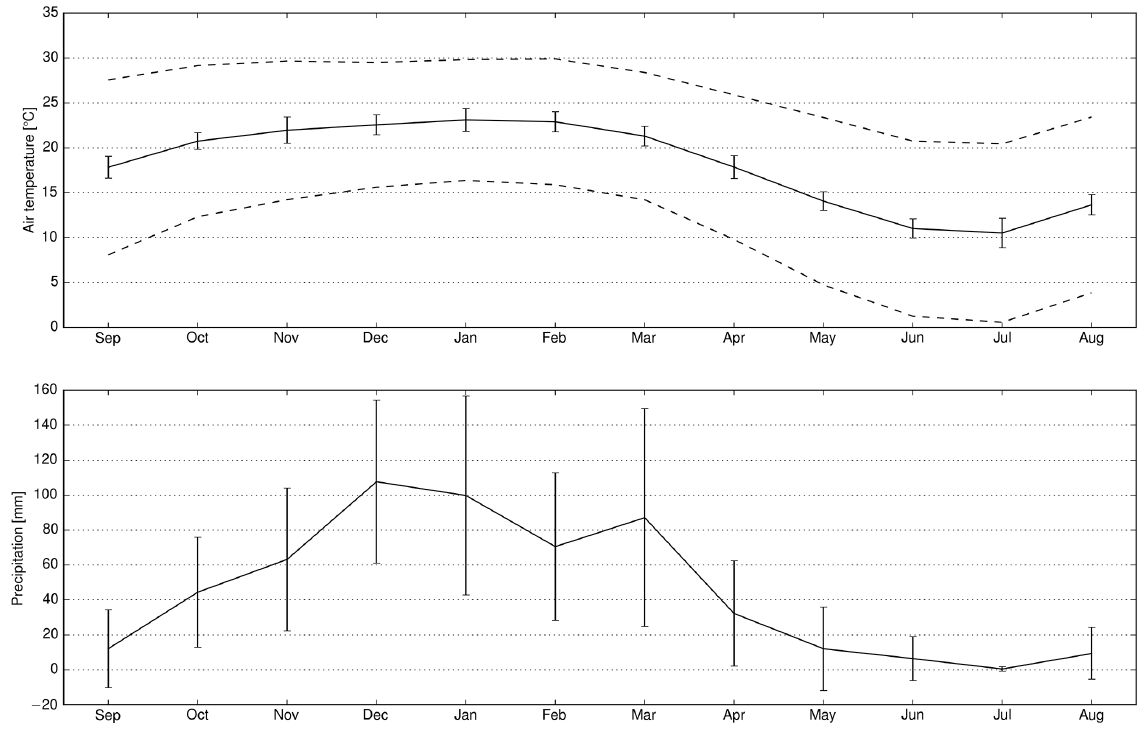
Figure 1. Monthly mean meteorological data from a nearby weather station in Potchefstroom during 1998–2014. The upper figure shows the mean (solid line) and minimum and maximum (dashed lines) air temperatures. The lower figure shows the mean precipitation. Error bars indicate ± 1 standard deviation. Table 1. Dominant plant species within the flux footprint. The plant species name is written in italics, whereas the roman text refers to the author. Some author names are